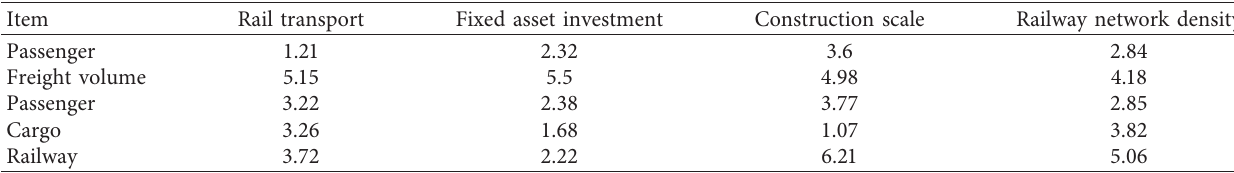
Table 10: Influencing factor data for railway impact indicators.